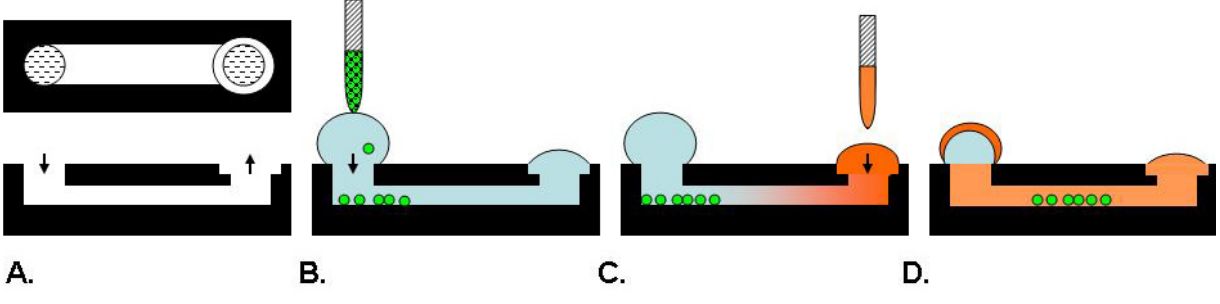
Figure 3. Microfluidic Assay. The device provides 2 ports for reagent delivery ( A ). Cells alone or in a matrix are introduced into the smaller port and adhere to the chamber bottom ( B ). Test agents are added to the larger port and a gradient sets up based on surface tension ( C ). Cells can be imaged to measure migration in response to the test agent ( D